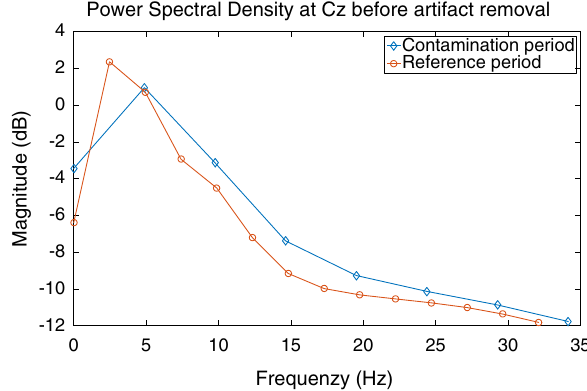
Fig. 1 Grand-average power spectral density for uncleaned data during the artifact contamination [ (cid:4) 100 100 ms] compared to the reference period [ (cid:4) 1200 (cid:4) 800